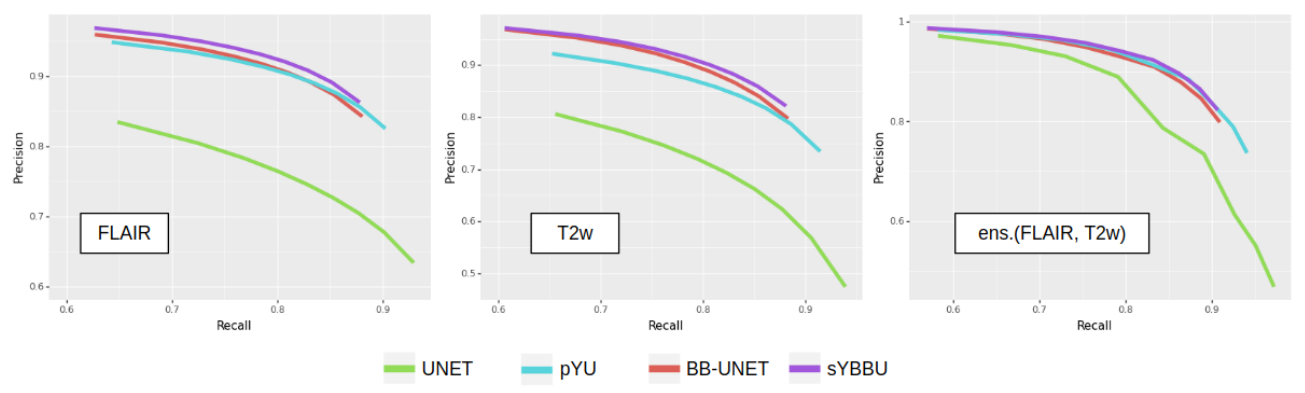
Figure 3. Mean precision-recall graphs of the different proposed segmentations on the TCGA-GBM test dataset. To focus on the most interesting part of the plot, we only plotted the precision-recall scores for thresholds between 0.1 and 0.9. From the left to the right, Using the FLAIR, using the T2w, and ens.(FLAIR,